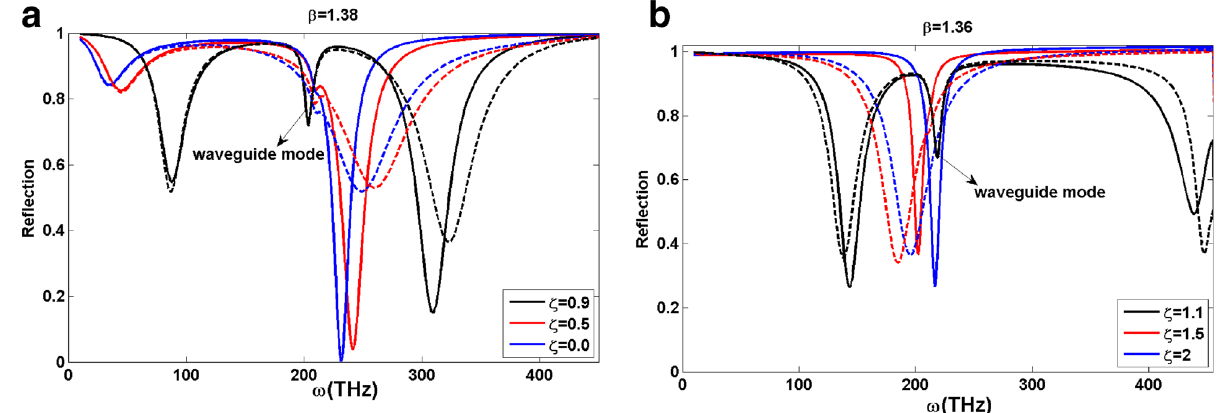
Figure 4. The calculated reflection spectrum of the forward (solid line) and backward (dashed line) in TWSM thin film. Panels ( a ), ( b ) correspond to type-I ( β of ζ , respectively. Here, we have considered ε p